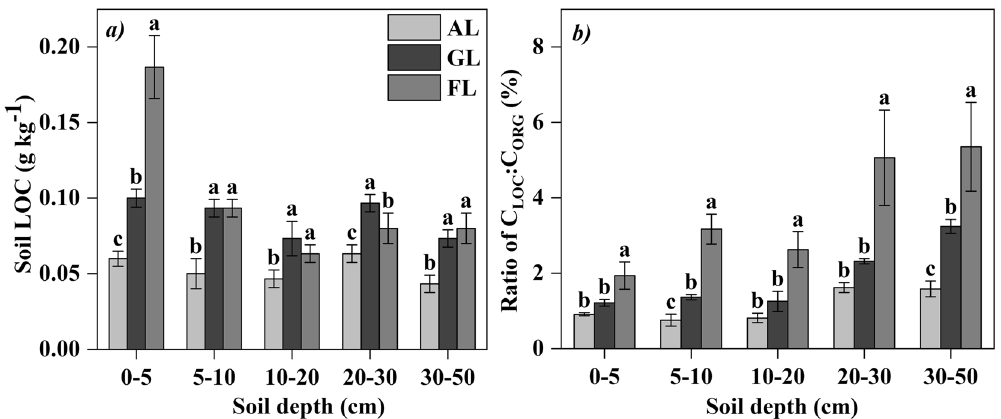
Figure 3. ( a ) Soil labile carbon (LOC) concentration and ( b ) the C LOC to C ORG ratios (mean ± SD) with different land uses. Different letters at the same soil depth indicate significant difference (n = 5, p < 0.05) among different land uses by one-way